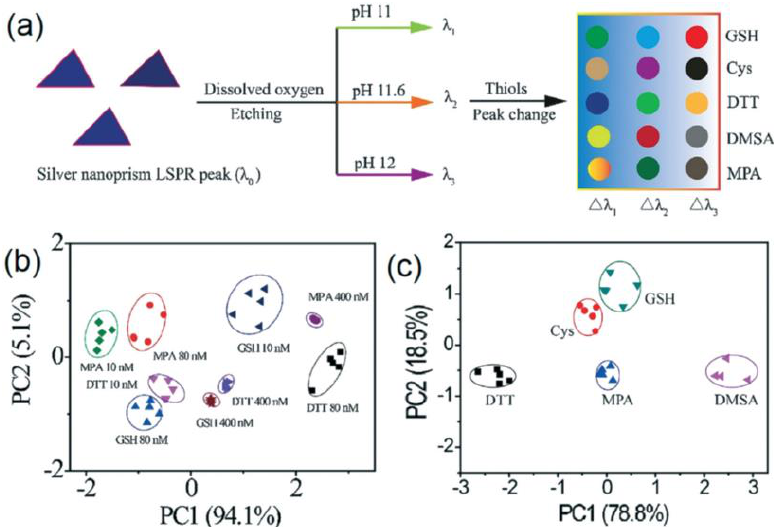
Figure 1. AgNPR-based colorimetric sensor for thiols: ( a ) sensing mechanism, ( b ) PCA (Principal Component Analysis) plot of the data matrix of three thiols at different concentrations, and ( c ) PCA plot of the data matrix of five thiols at a concentration of 400 nM [43].